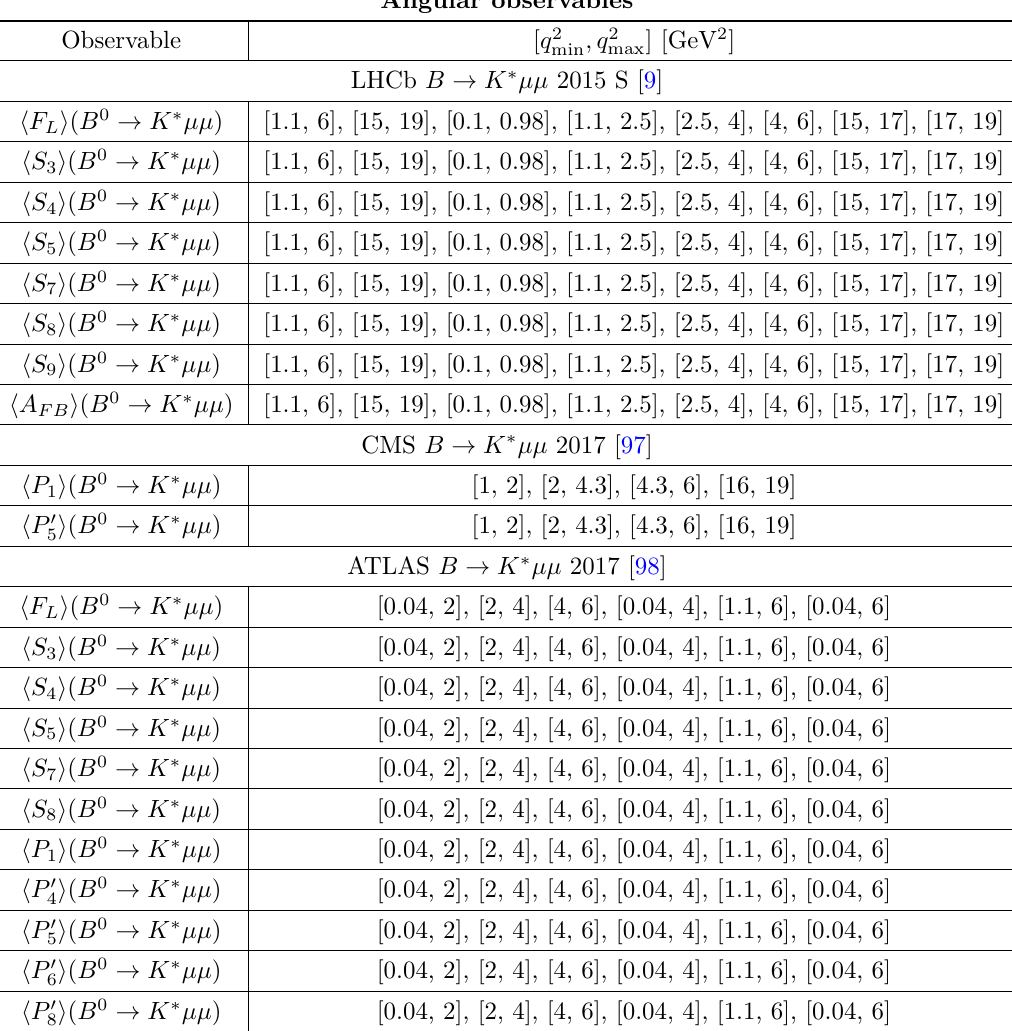
Table 6 . List of angular observables used in the global (cid:12)t in addition to the ‘clean’